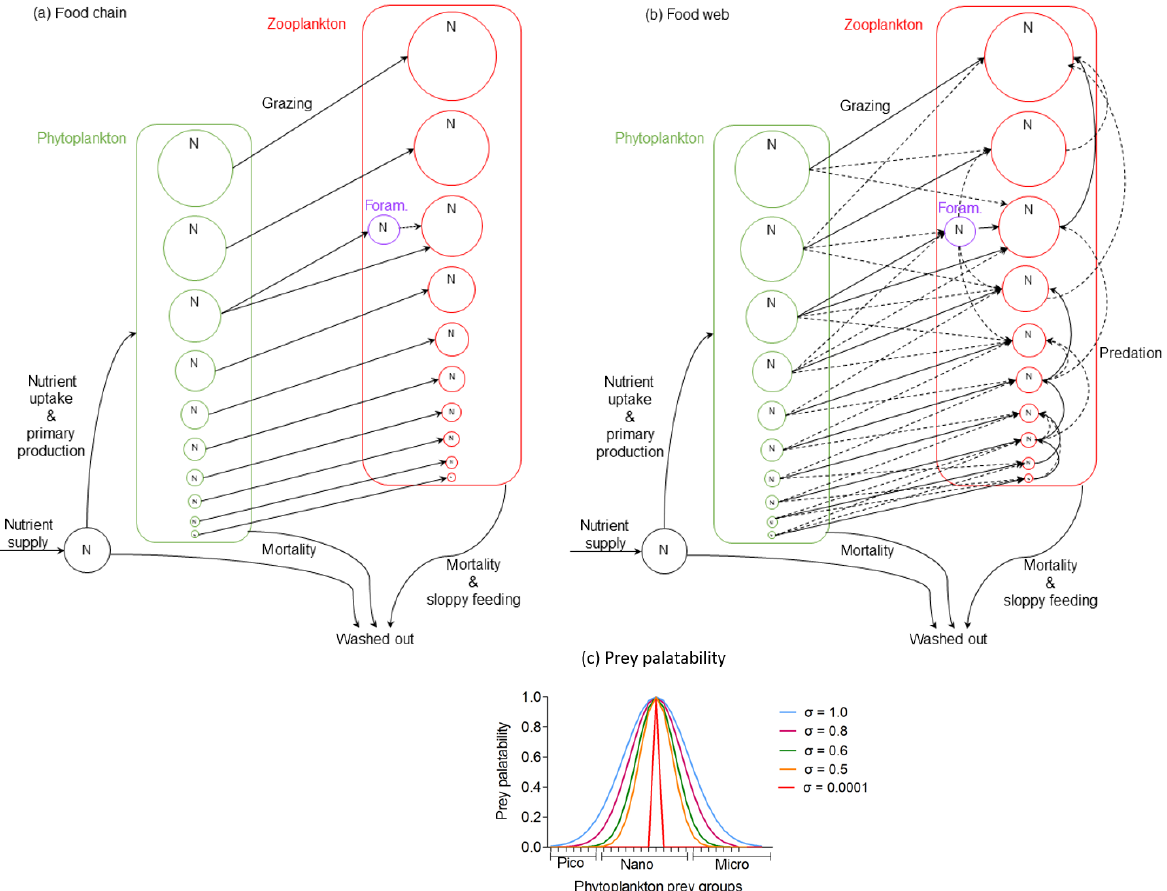
Figure 2. Schematic description of the two model versions of the size trait-based model of planktonic foraminifera: (a) food chain and (b) food web (adopted with permission from Ward et al., 2012). Note that the figure does not present the accurate position of the planktonic foraminifera size group ran in the model but a generic position to illustrate how they interact with the rest of the plankton community. (c) Illustration of the prey palatability of one herbivorous predator (160µm size) with phytoplankton prey groups. Size specialist predator (present in the food chain version) is characterized by standard deviation ( σ ) equal to 0.0001. Size generalist predator (present in the food web version) is characterized by σ ≥ 0 .